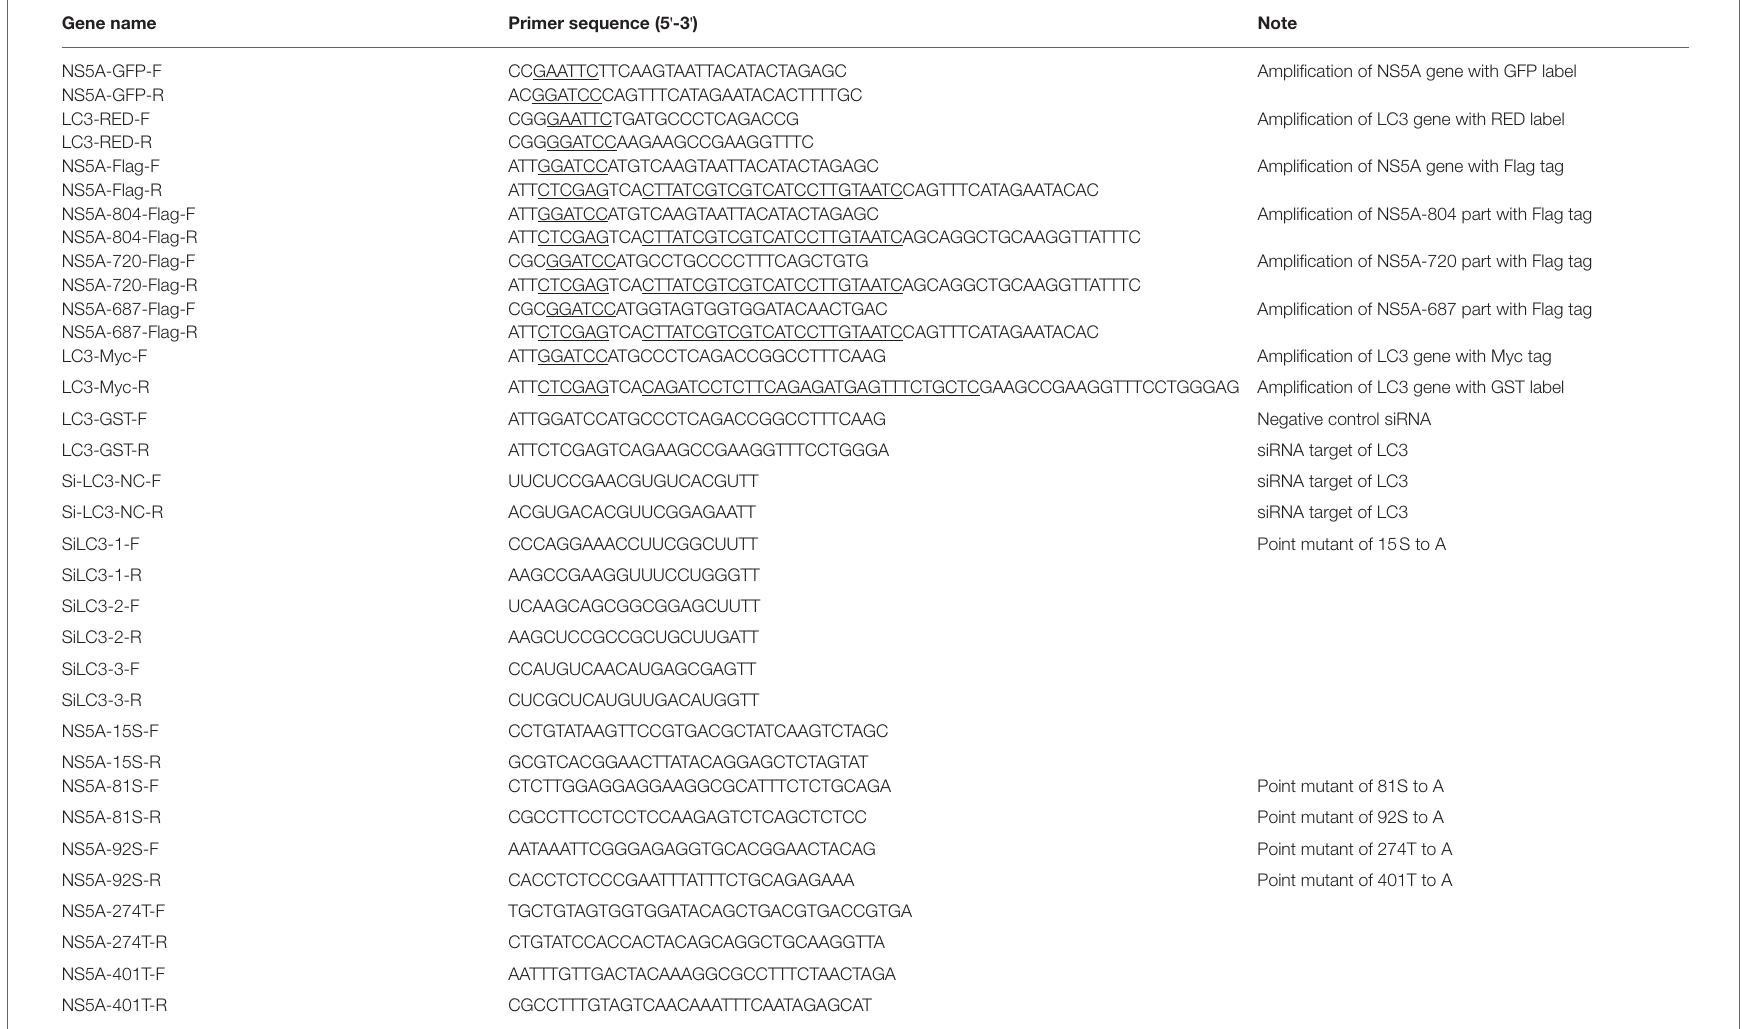
TABLE 1 | Sequence of PCR